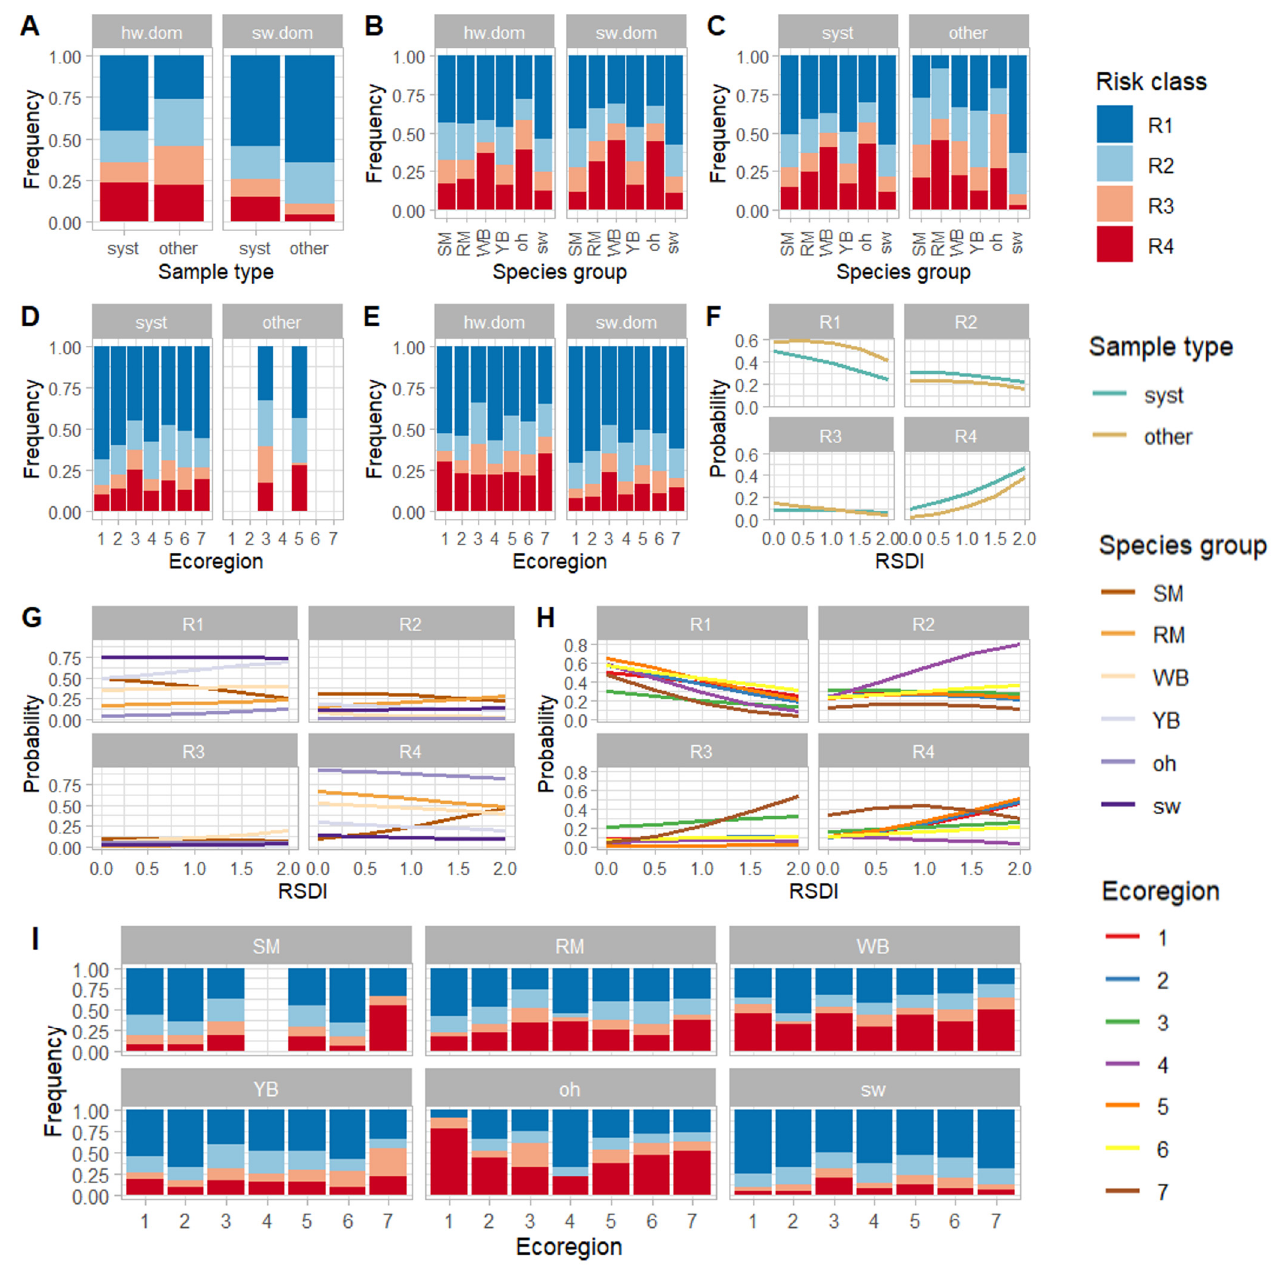
Figure 7. Risk class of trees (R1–R4) (N = 25 516) depending on plot dominance (hardwood domi-nated (“hw.dom”) or softwood dominated (“sw.dom”) and sample type (systematic “syst” or “other”) ( A ), plot dominance and grouped species (SM: sugar maple; RM: red maple; WB: white birch; YB: yellow birch; oh: other hardwoods; sw: softwoods) ( B ), sample type and species group ( C ), sample type and ecoregion ( D ), plot dominance and ecoregion ( E ), sample type and stand density (RSDI) ( F ), RSDI and species group ( G ), RSDI and ecoregion ( H ), species group and ecoregion ( I ).